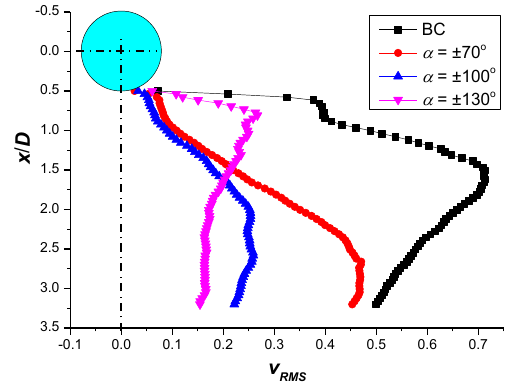
Fig. 7. Variation of v rms along the wake centreline for the BC, A70, A100 and A130